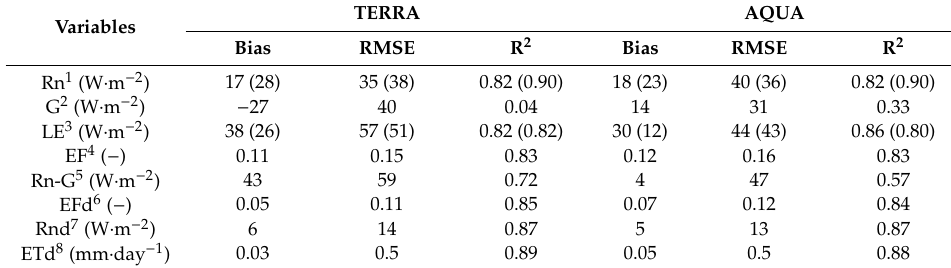
Table 4. Skill scores of E3S (EVASPA S-SEBI Sahel) flux estimates versus SiSPAT simulations or plot observations (when available, in brackets), for instantaneous fluxes at satellite overpass (top five lines) and day-integrated fluxes (last three lines), with TERRA and AQUA satellite sources, over 2005–2008. Determination coe ffi cient (R 2 ) is given without unit whereas Bias and root mean square error (RSME) are given in W · m − 2 or in mm · day − 1 or without unit according the